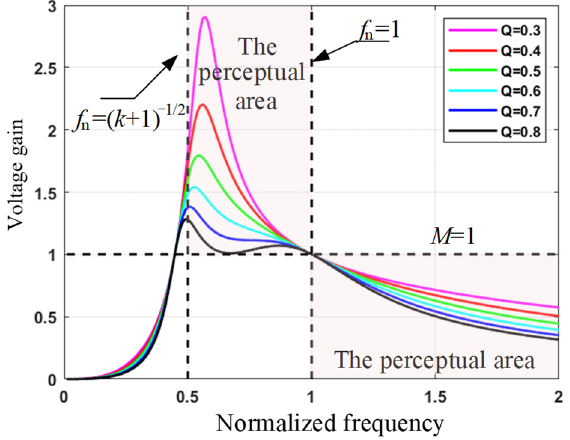
Figure 8. Resistive divider for bidirectional CLLLC resonant converter (k = 2). As seen from Figure 8, the overlap area on the upper side of the line M = 1 and the right side of f n = ( k + 1) − 1/2 is the inductive region. The inductive region in the region where